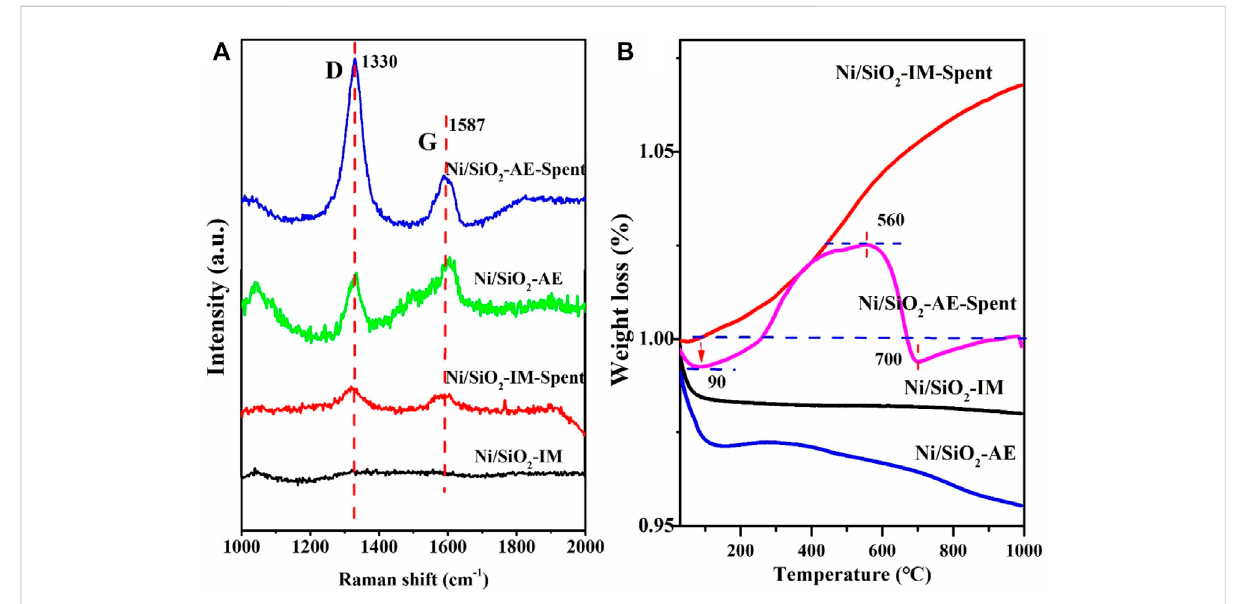
FIGURE 8 Raman spectra (A) and TG curves (B) of different Ni-based